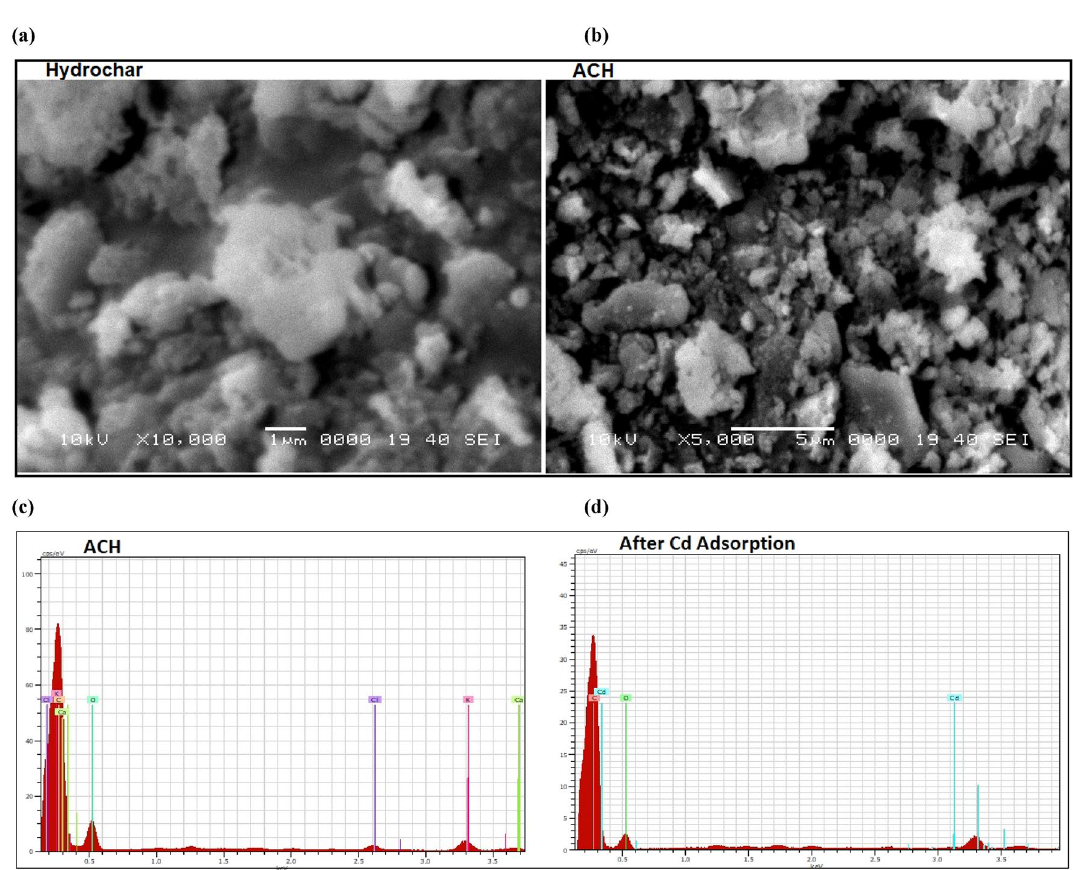
Figure 2. SEM images of hydrochar ( a ), ACH ( b ) and EDS spectra before ( c ) and after Cd adsorption ( d